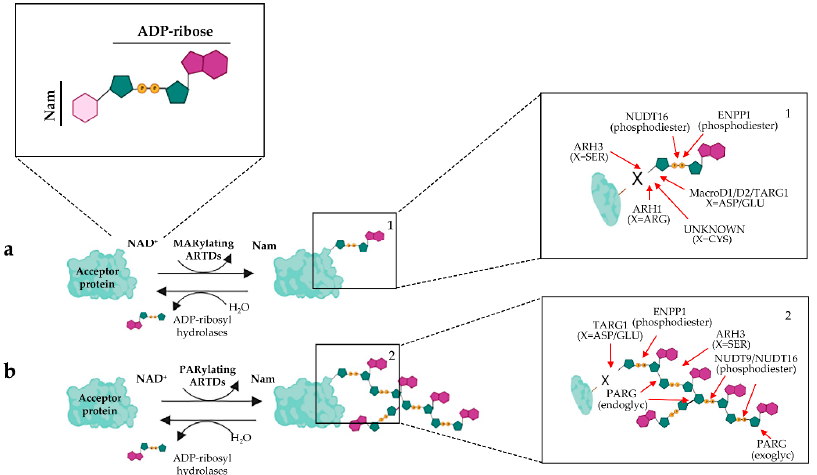
Figure 1. Schematic representation of the ADP-ribosylation reaction onto acceptor protein. ( a ) Mono-ADP-ribosylation reaction is catalyzed by human ARTDs in the presence of the NAD + . Inset 1. The modification is reversed by selective ADP-ribosylhydrolases (MacroD1, MacroD2, TARG1, ARH1, ARH3) that display different amino acid–ADP-ribose linkage specificity, and by phosphodiesterases (NUDT16 and ENPP1). ( b ) Poly-ADP-ribosylation reaction is catalyzed by human ARTDs. Inset 2. Linear or branched chains of poly-ADP-ribose are hydrolyzed by selective ADP-riboshydrolases (PARG, ARH3, TARG1) and by phosphodiesterases (NUDT16 and ENPP1). Further details are reported in the text. ARH1/ARH3, ADP-ribosyl acceptor hydrolases 1/3; NUDT16, nudix hydroxylase 16; PARG, poly-ADP-ribosyl glycohydrolase (endo-glyc, endo-glycolytic activity; exo-glyc, exo-glycolitic activity); TARG1, Terminal ADP-ribose glycosylhydrolase 1.